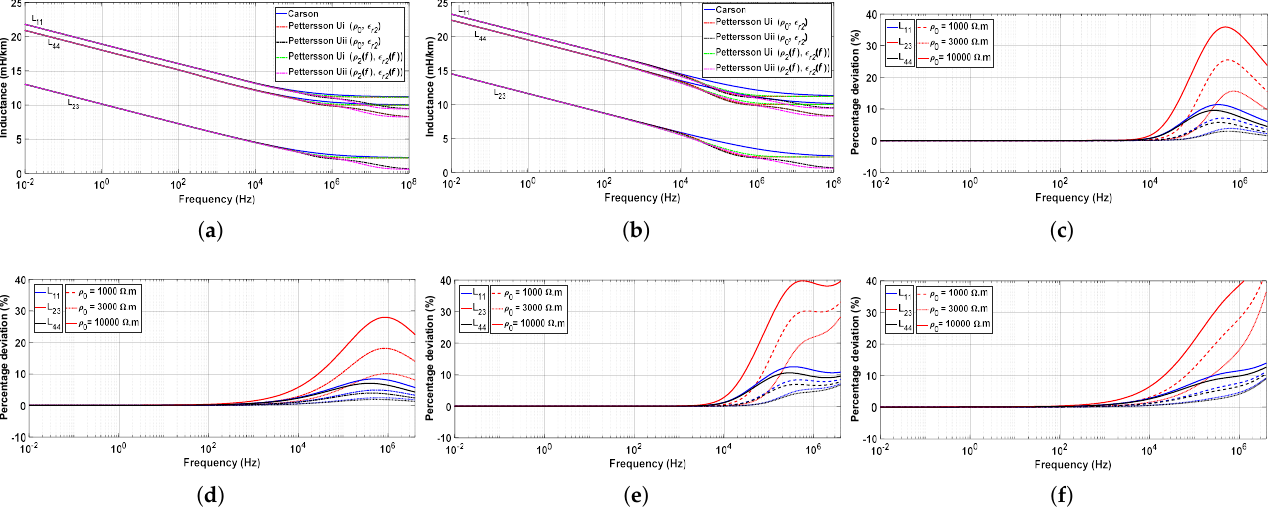
Figure 9. ( a ) Inductance (mH/km) for the 1000 Ω .m; ( b ) Inductance (mH/km) for the 10,000 Ω .m; ( c ) Percentage deviation between Carson’s and Pettersson’s formulation Ui; ( d ) Percentage deviation between Carson’s and Pettersson’s formulation Ui with frequency dependence; ( e ) Percentage deviation between Carson’s and Pettersson’s formulation Uii; ( f ) Percentage deviation between Carson’s and Pettersson’s formulation Uii with frequency